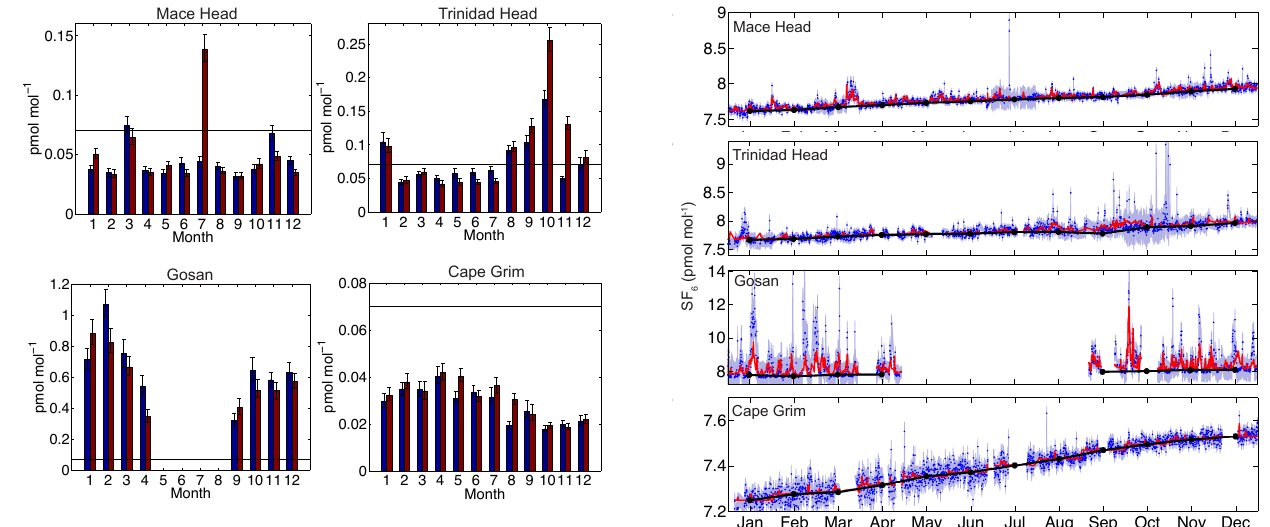
Fig. 6. Simulated 2012 SF 6 mole fractions (red line) and observa- tions (blue dot) at each AGAGE station. Note that each station is plotted with a different y axis range. Shading represents the 16th to 84th percentiles of the posterior model-measurement uncertainty distributions derived in the inversion. Black circles indicate the baseline values derived at each